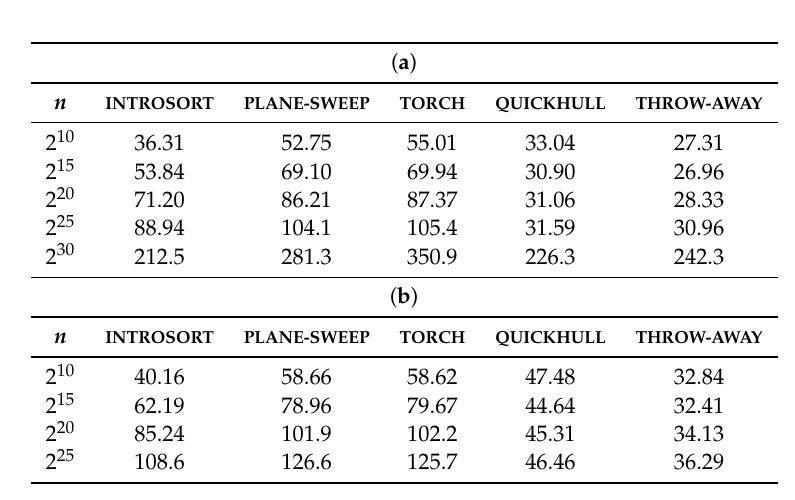
Table 6. The running time of the competitors [in nanoseconds per point] for the disc data set: ( a ) Linux computer, ( b ) Windows computer.